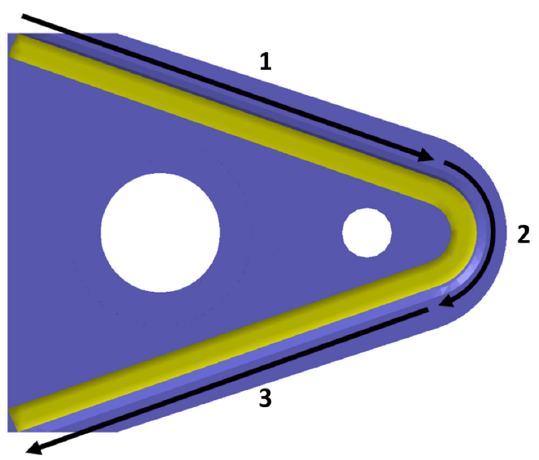
Figure 5. Dividing the weld into separate segments with different melt zones for the segmented simulation. SCV